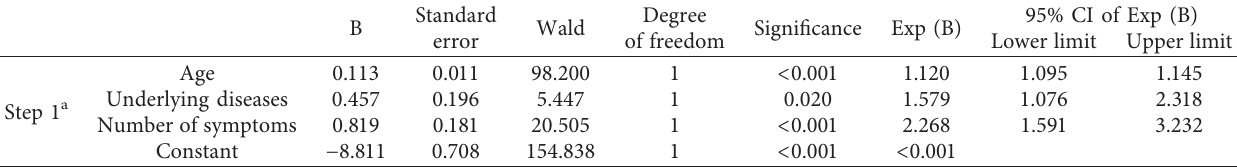
Table 9: Factors affecting the COVID-19 patients developing severe illnesses after assignment.